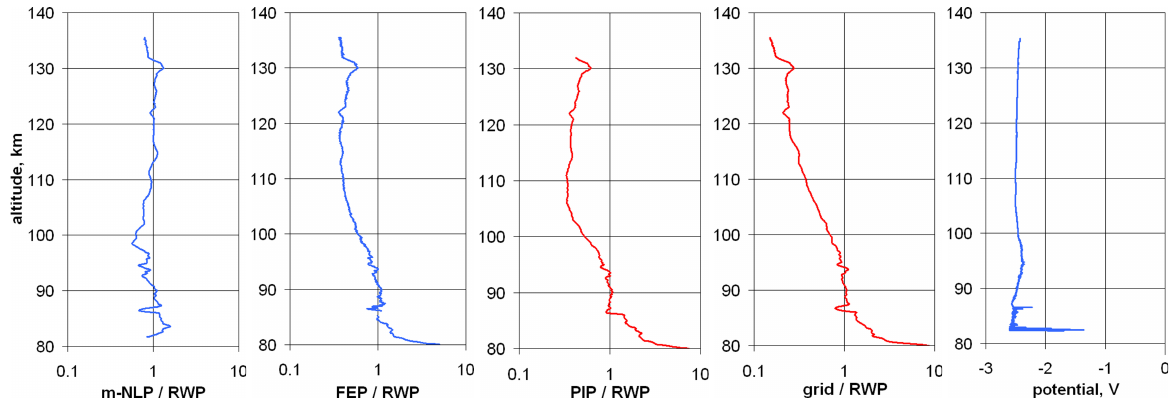
Fig. 10. As Fig. 4, but flight